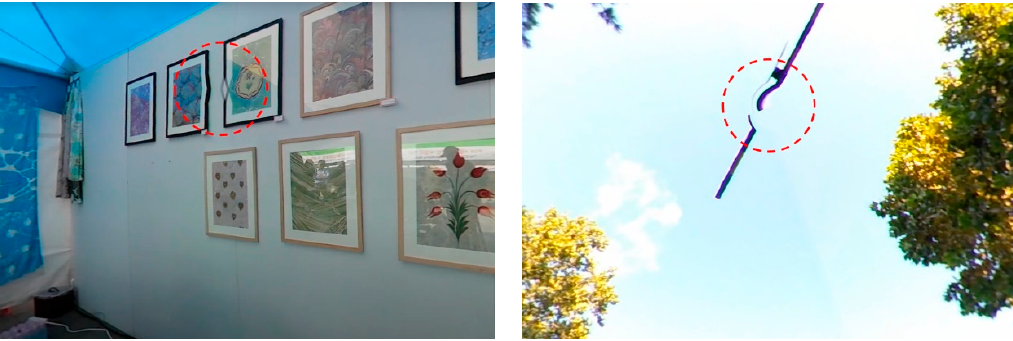
Figure 2. Errors of stitching in a 360° video.